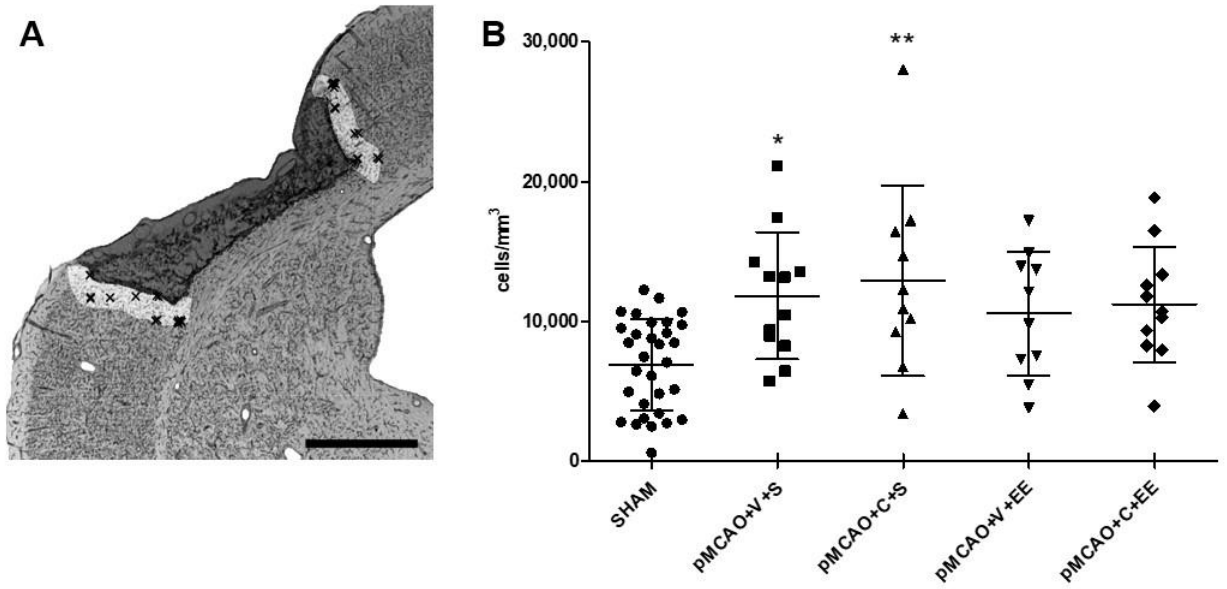
Figure 2. Stereological quantification of perilesional inflammation. Delineation of the perilesional cortex 200 µm from the glial scar border of the ischemic infarct core ( A ). There was an ischemia-induced increase in the number of ionized calcium-binding adaptor molecule 1 (Iba1+) cells in the perilesional cortex ( B ). Statistical significance: * p < 0.05, ** p < 0.01 (compared to the pooled SHAM group) (one-way ANOVA followed by Bonferroni multiple comparisons test). Data are expressed as mean ± SD. SHAM = sham-operated; pMCAO = permanent middle cerebral artery occlusion; V = 48 h vehicle administration; C = 48 h cell administration; S = standard housing; EE = enriched environment. Scale bar 1 mm ( A ).